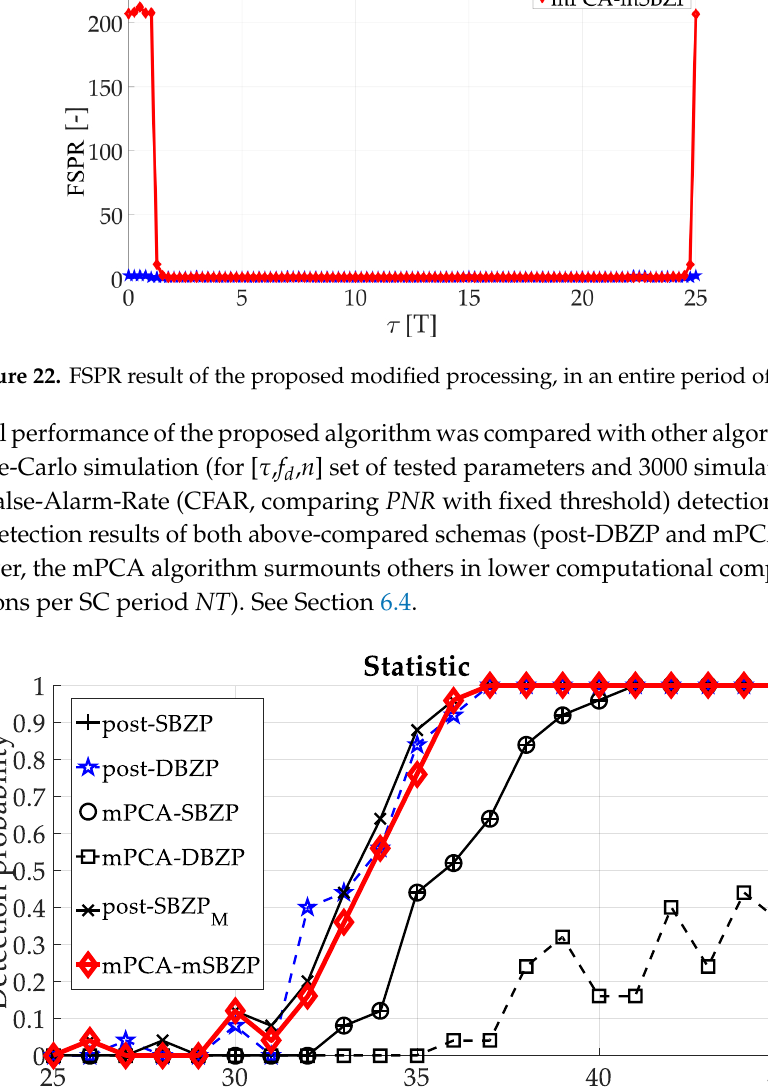
Figure 24. CAF of mPCA mSBZP for SC algorithm for τ = (1/2) T. CAF ( left ), Dopler shift domain ( middle ), Code phase domain ( right ).